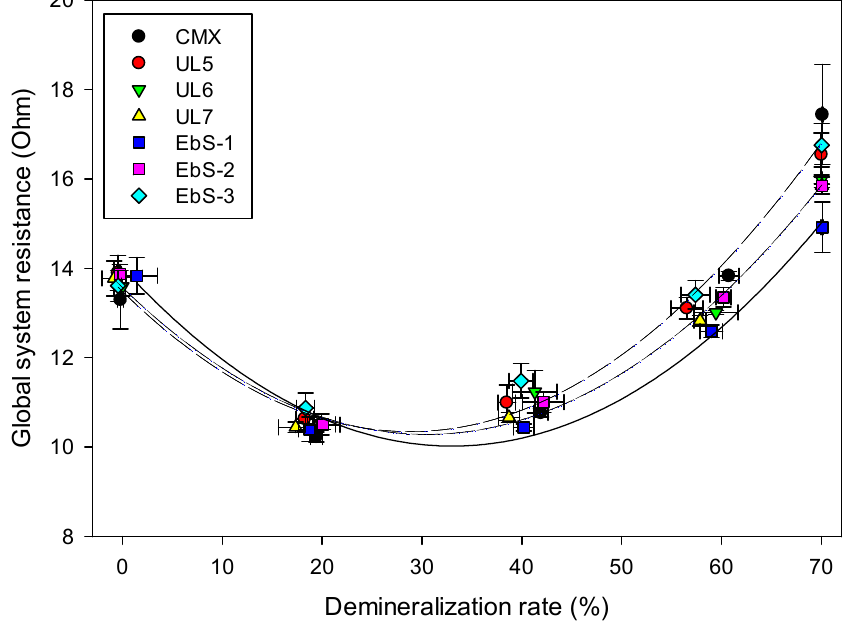
Figure 7. Evolution of global system resistance during whey demineralization as a function of demineralization rate with hIEMs or CMX.